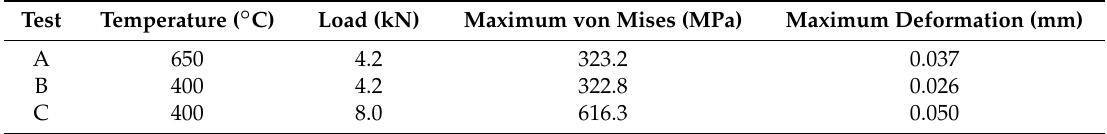
Figure 16. ( a ) Equivalent stress contours of valve A. ( b ) total deformation contours of valve A; ( c ) safety factor contours of valve A; ( d ) safety factor contours of valve B. Table 8. Finite element method results of three HHSVs.